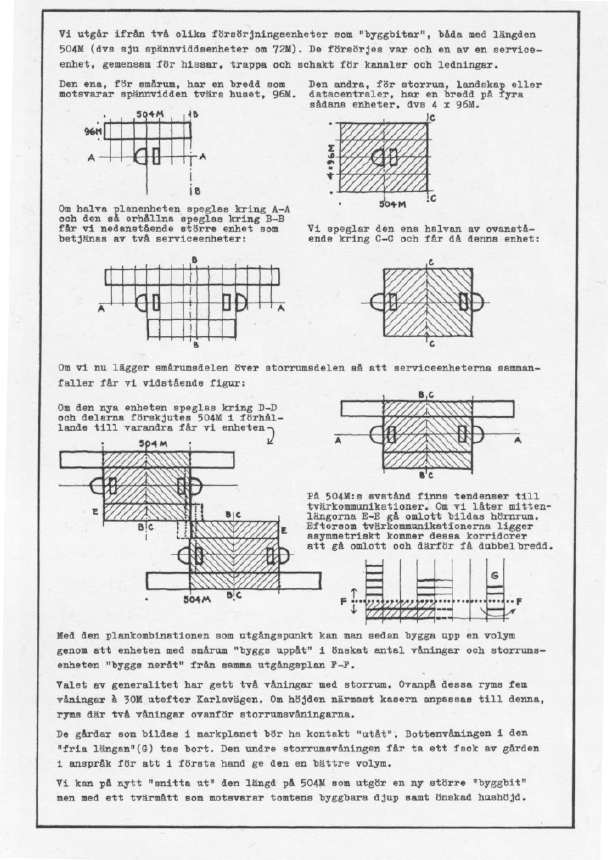
Figure 3. The systematic and abstract program for the structure of Garnisonen with space both for office cells and computer rooms.